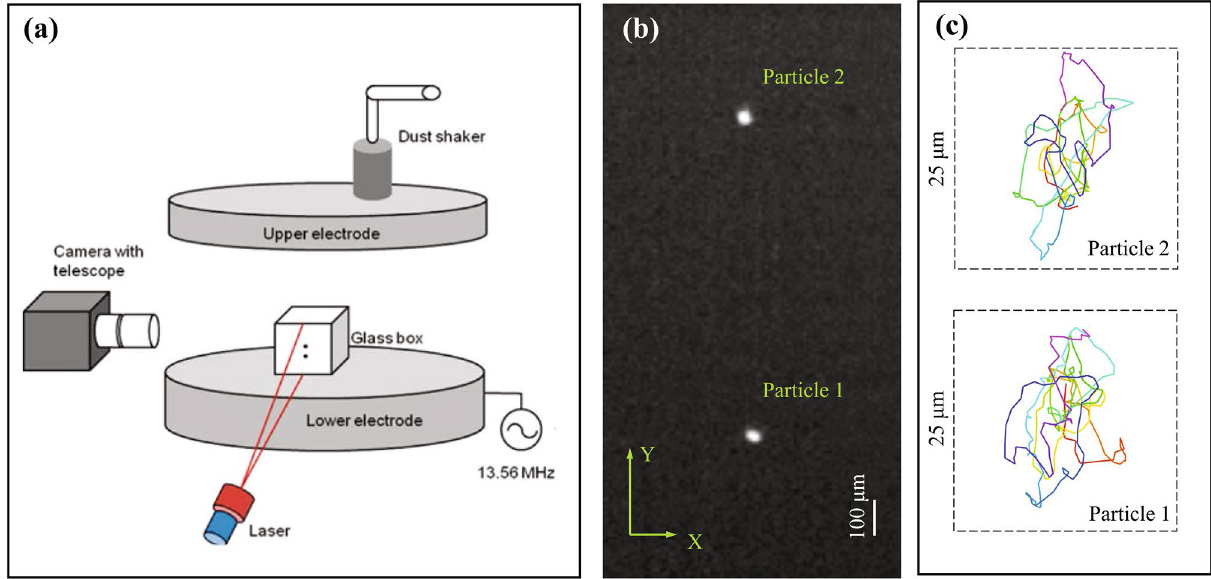
Figure 1. ( a ) Sketch of the experimental setup with a RF discharge. A 12.7 mm × 12.7 mm × 12.7 mm glass box placed on the lower electrode creates the electric potential needed to confine the microparticles. ( b ) The video frame with the image of the particles levitating in the glass box above the lower electrode under a pressure of 136 mTorr and RF power of 2.33 W. ( c ) The trajectories of the particles obtained as a result of computer processing of the video record of their movement for 1